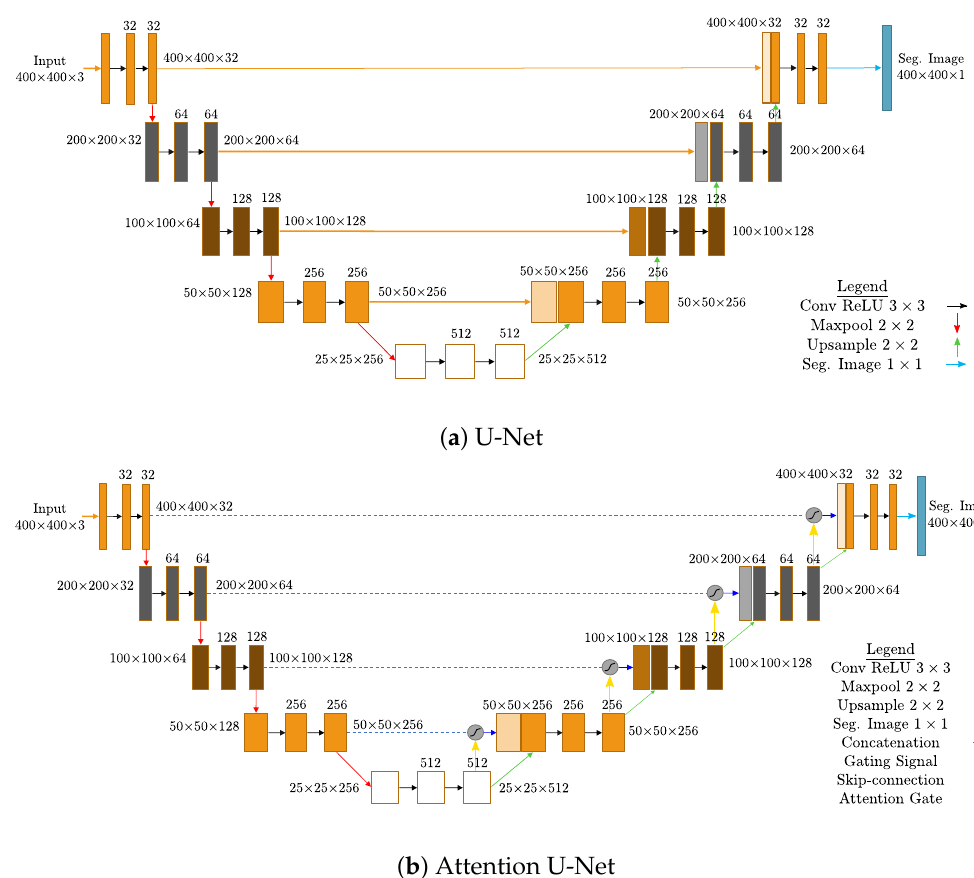
Figure 1. The U-Net ( a ) architecture. The contracting path ( left ) encodes information by down- sampling the input image five times. The expanding path ( right ) decodes information using the contracting path to improve on the spatial information. The Attention U-Net ( b ) architecture consists of the original U-Net architecture along with attention gates in the contracting path, which are used to avoid low-level features being repeatedly